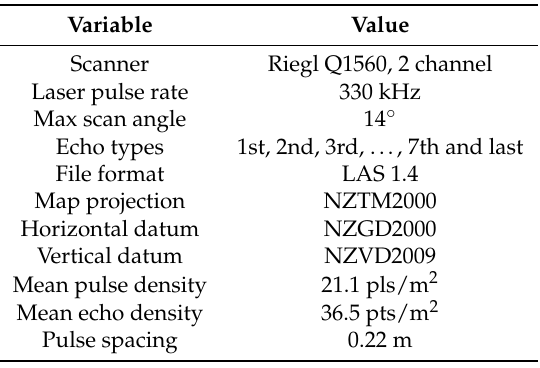
Table 2. Campaign settings for ALS data